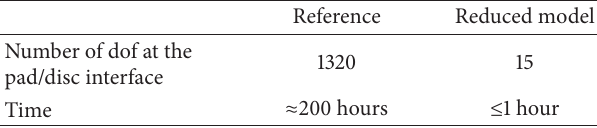
Table 3: Computational costs of the proposed reduced method and the reference